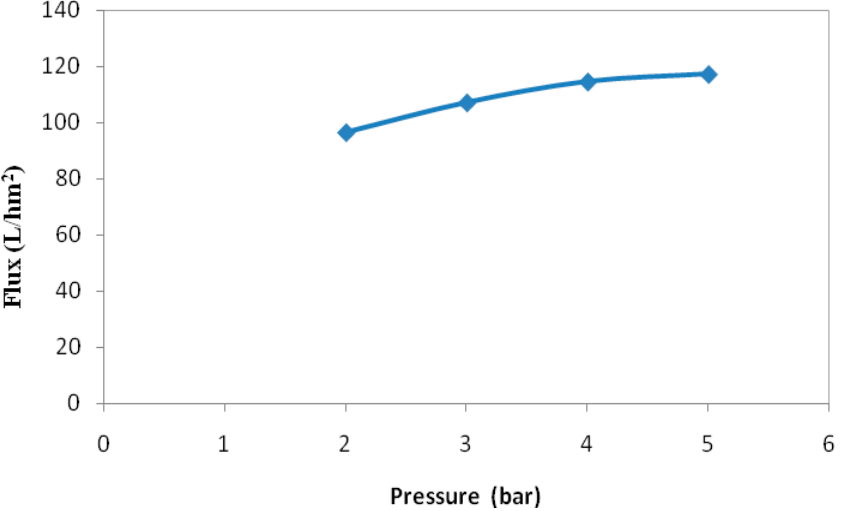
Figure 5. Evolution of stabilized permeate flux with applied pressure at: VCF = 1.03 g/L, and T = 20 °C.